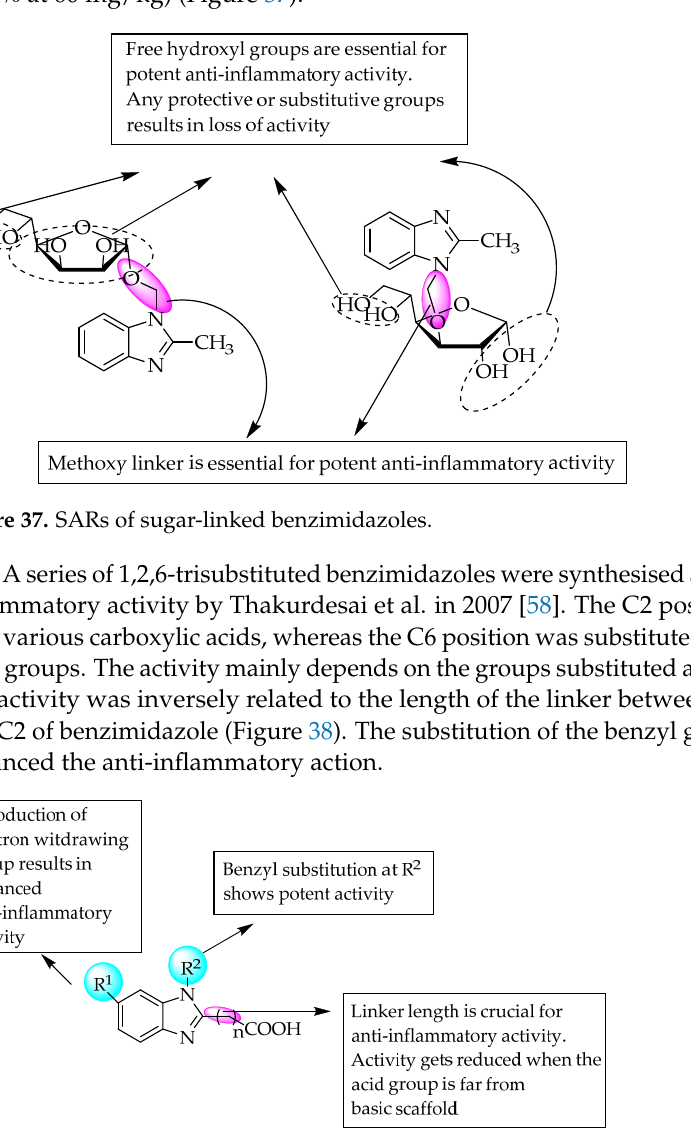
Figure 38 . SARs of 1,2,6-trisubstituted benzimidazoles. different substituents has encouraged researchers to concentrate on fused benzimidaz- oles. Toja et al. (1984) first reported the anti-inflammatory activity of fused imidazole derivatives substituted at the 1- and 2-positions (Figure 39), which were non-acidic agents [59]. The anti-inflammatory activity of the compounds at 100 mg/kg p.o. doses was evaluated using the carrageenan-induced rat paw oedema method. The SARs of the naphthimidazoles revealed that 4-methoxyphenyl substitution at the 2-position of the imidazole nucleus favoured anti-inflammatory activity (45–50% paw oedema inhibition), while a chloro- or hydroxy-substituted phenyl moiety at this position reduced the activ- ity (1–20% paw oedema inhibition).